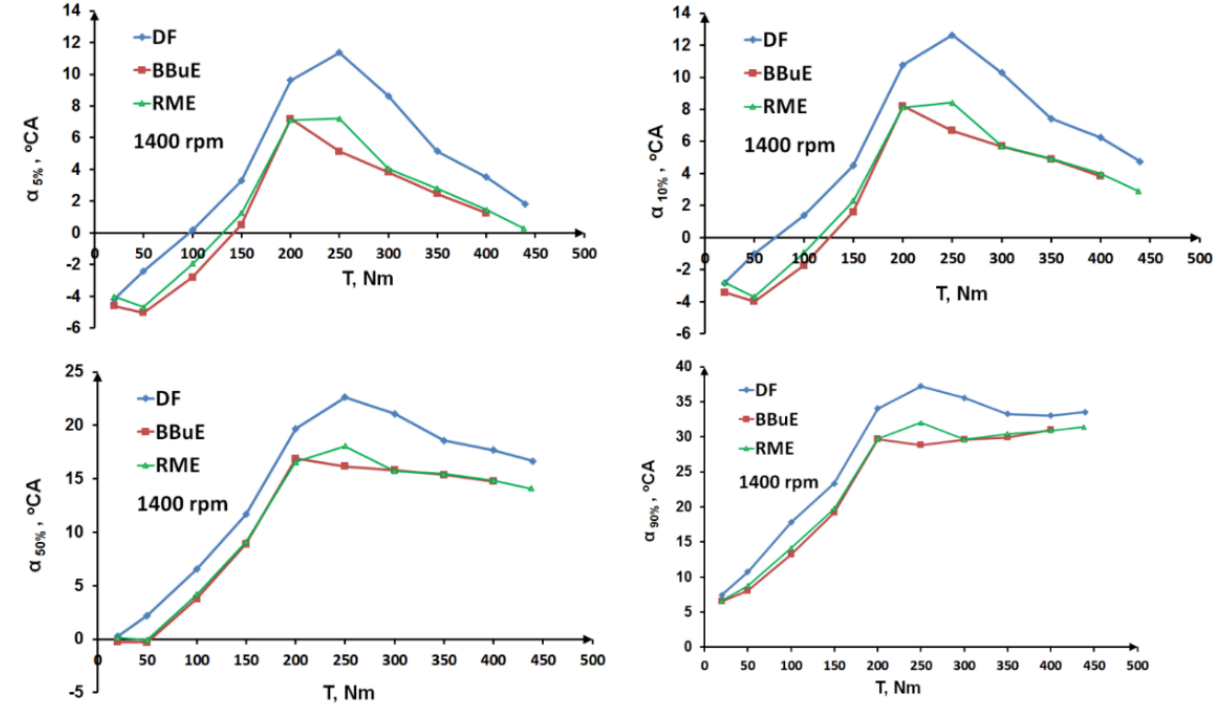
Figure 16. Angular values of crankshaft rotation of the engine at which 5, 10, 50, and 90% of the fuel dose was burned.